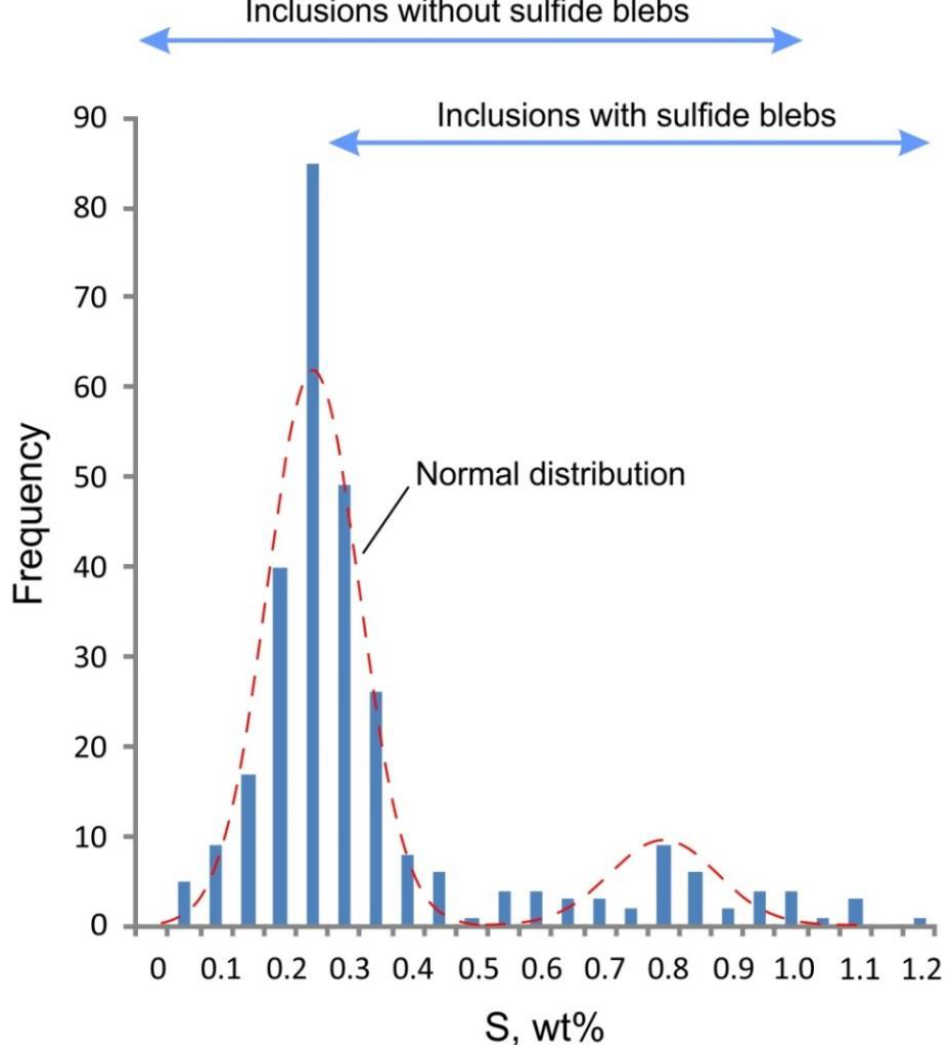
Figure 3. Histogram displaying the distribution of sulfur concentrations in MI from the 1941 Tolbachik eruption; data is the same as for the diagram shown in Figure 2. Along with volatile components, the isotopic composition of sulfur in 35 melt inclu- sions was measured by SIMS (Table 1, Figure 4). The δ 34 S values range from 4.69 ± 2.03 ‰ (2 σ ), with a mean almost identical to the global average for island-arc rocks ( δ 34 S = +4.5 ‰, Figure 3) and the sulfur isotopic compositions of the eruptive gases from the 2013 Tolbachik eruption ( δ 34 S = +4.5, our data). No significant correlations between δ 34 S and total S, or any other element or volatile component were observed. According to Gurenko, A.A. [23], sulfur in MI from scoria does not form significant correlations with either volatile elements or rock-forming oxides, which is in agreement with our